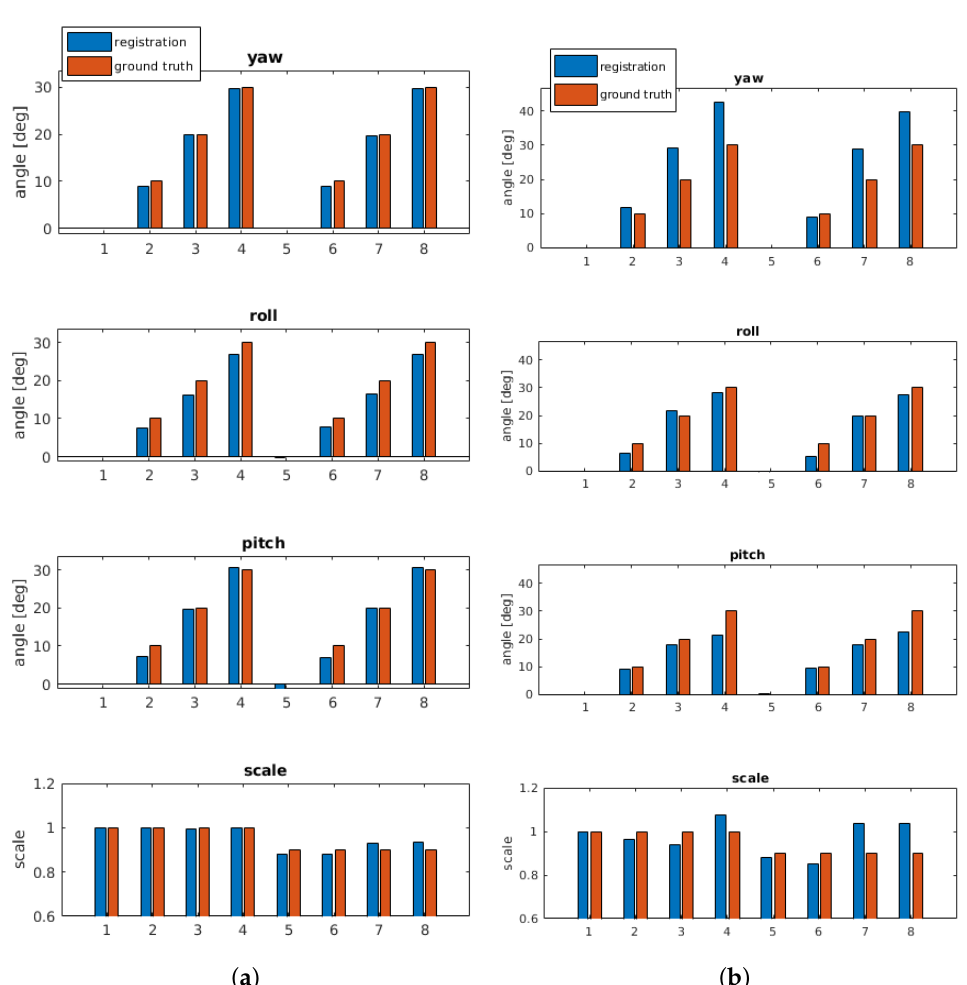
Figure 15. Results for B2 bone with artificial transformations. ( a ) Bone B2 (person 1, center position) is rotated up to 30 ◦ and scaled with the same rotation sequence. The segmented bone is matched within the tissue of a different MRT scan (different hand position) from the same person. ( b ) Bone B2 (person 1, center position) is rotated up to 30 ◦ and scaled with the same rotation sequence. The segmented bone (person 1) is matched within the tissue of a MRT scan from person